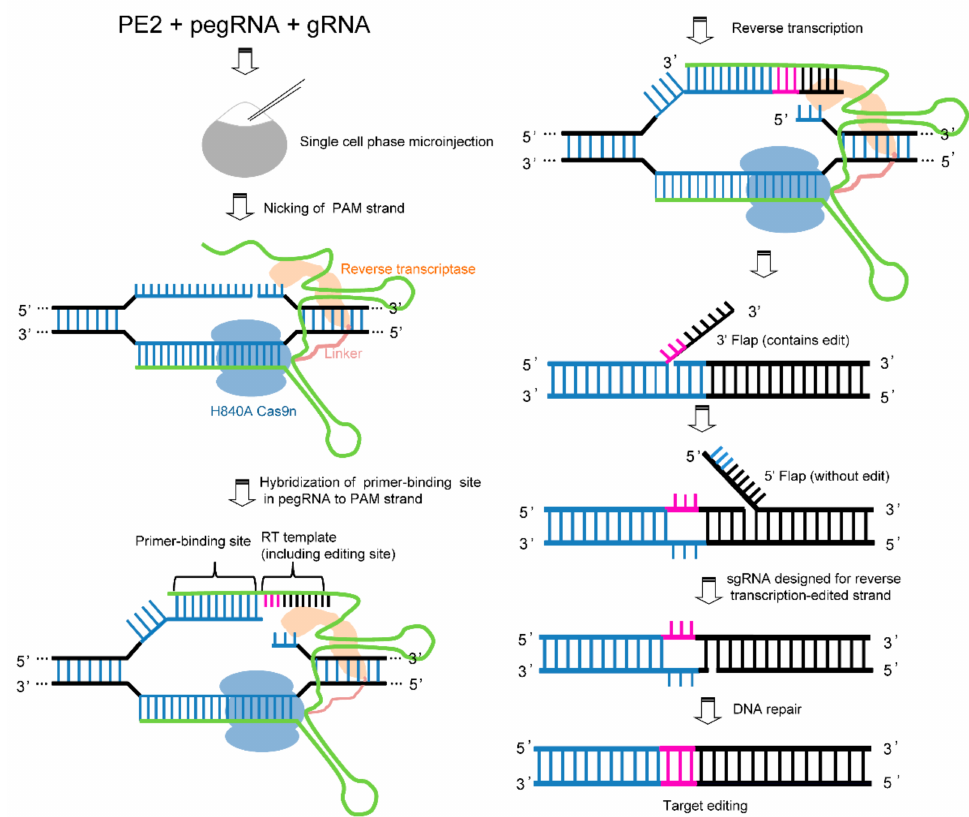
Figure 5. Prime editing technology. The prime editor (PE) is a H840A Cas9n and reverse transcriptase (RT) fusion protein coupled with a prime editing guide RNA (pegRNA). The PE2:pegRNA complex binds to the target DNA and nicks the PAM-containing strand. To improve editing efficiency, additional gRNA nicking of the complementary strand is preferred. During the repair process, the primer-binding site in pegRNA hybridizes to the PAM strand. The RT template of the pegRNA is converted into new DNA by RT. Under the action of proteins, equilibration between the edited 3 (cid:48) flap and the unedited 5 (cid:48) flap can be achieved. Finally, DNA repair results in stably edited DNA. 13.